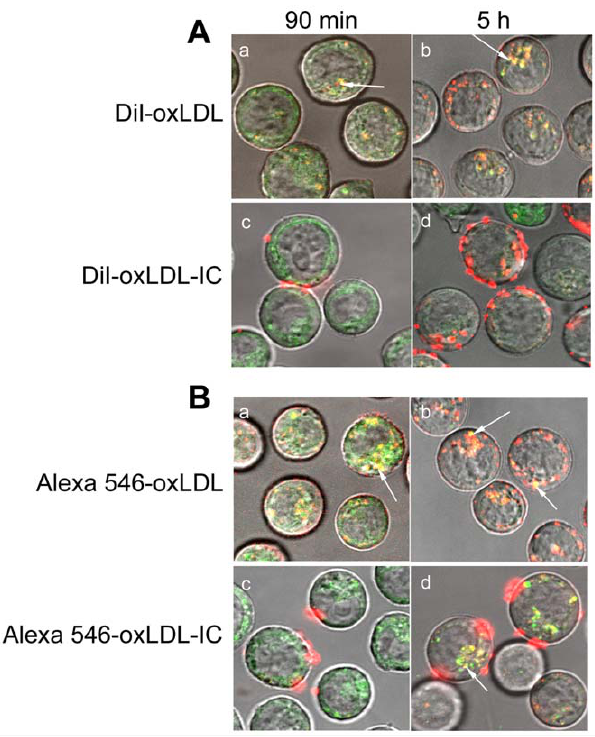
Figure 2. Localization of labeled lipoprotein moieties of oxLDL and oxLDL-IC in endosomal vesicles. U937 cells were treated with endosomal marker (Alexa 488-transferrin, green) and with either DiI- labeled lipid moiety (red) ( A ), or Alexa 546-labeled protein moiety (red) ( B ) for 90 min and 5 h. Cells were treated with Alexa 488-transferrin (5 m g/ml) and with either labeled oxLDL (24 m g/ml) or labeled oxLDL-IC (32 m g/ml), fixed with 4% formaldehyde, suspended in sealed capillaries and visualized using Zeiss LSM 510 laser scanning confocal microscope. Arrows point at co-localization of lipid and apolipoprotein moities of oxLDL and oxLDL-IC with Alexa 488-transferrin.